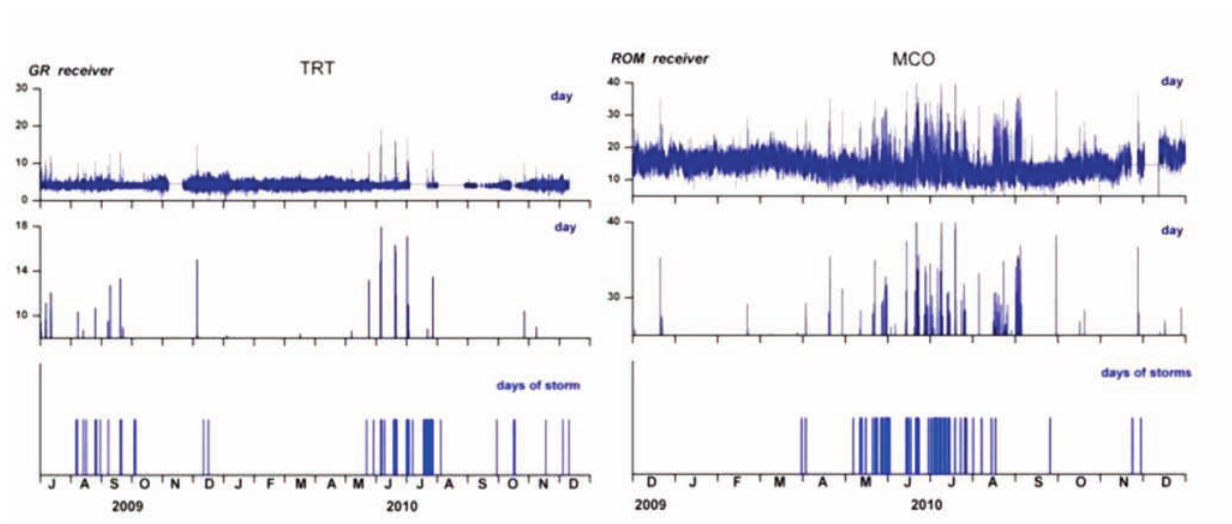
Figure 4. Day-time transmitter radio signals and storm days collected from July 2009 to December 2010. Left: Intensities of the TRT (180 kHz) transmitter signals collected by the GR receiver (Figure 1). Right: Intensities of the MCO (216 kHz) transmitter signals collected by the ROM receiver (Figure 1). The storm days are also reported for both. The second panels from the top show the day-time intensities on an enlarged scale to clearly show correspondence with the